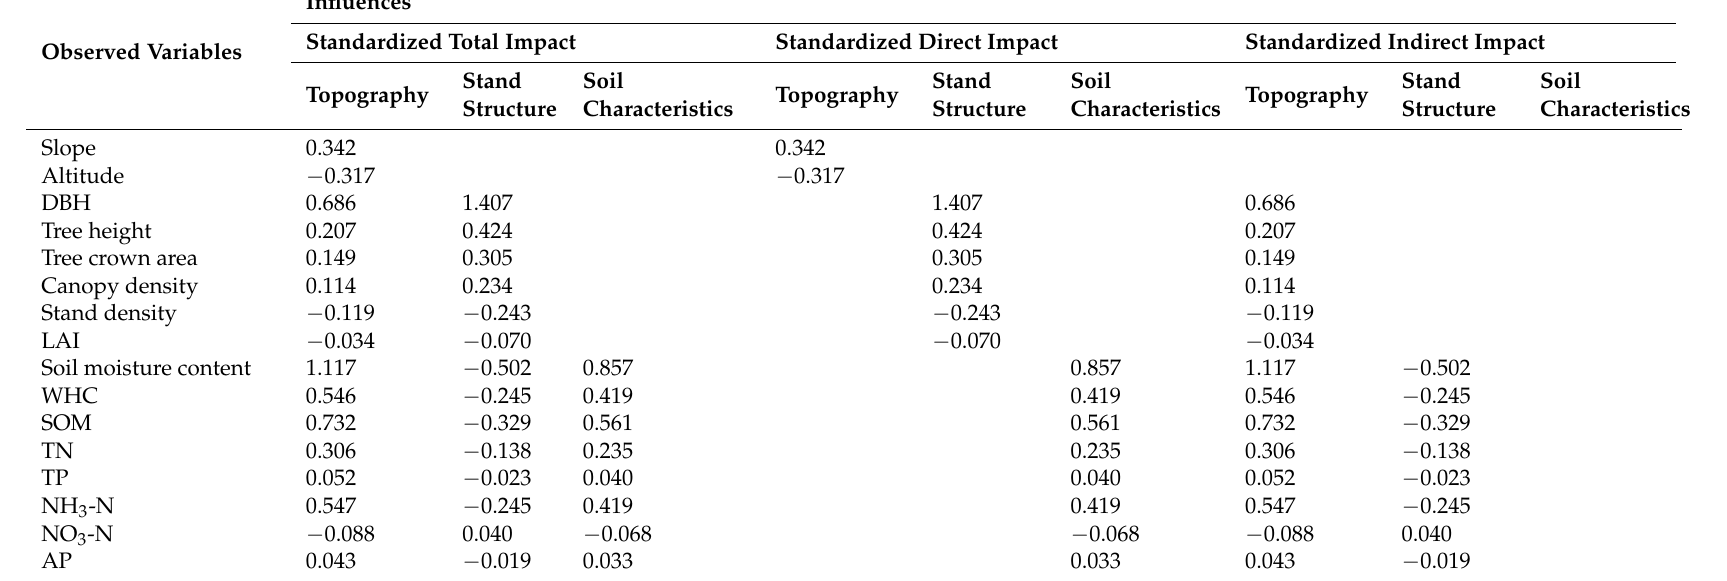
Table 5. Standardized influence coefficients between observed variables and latent variables in the structural equation model of Robinia pseudoacacia and Pinus tabulaeformis mixed plantations in the Caijiachuan